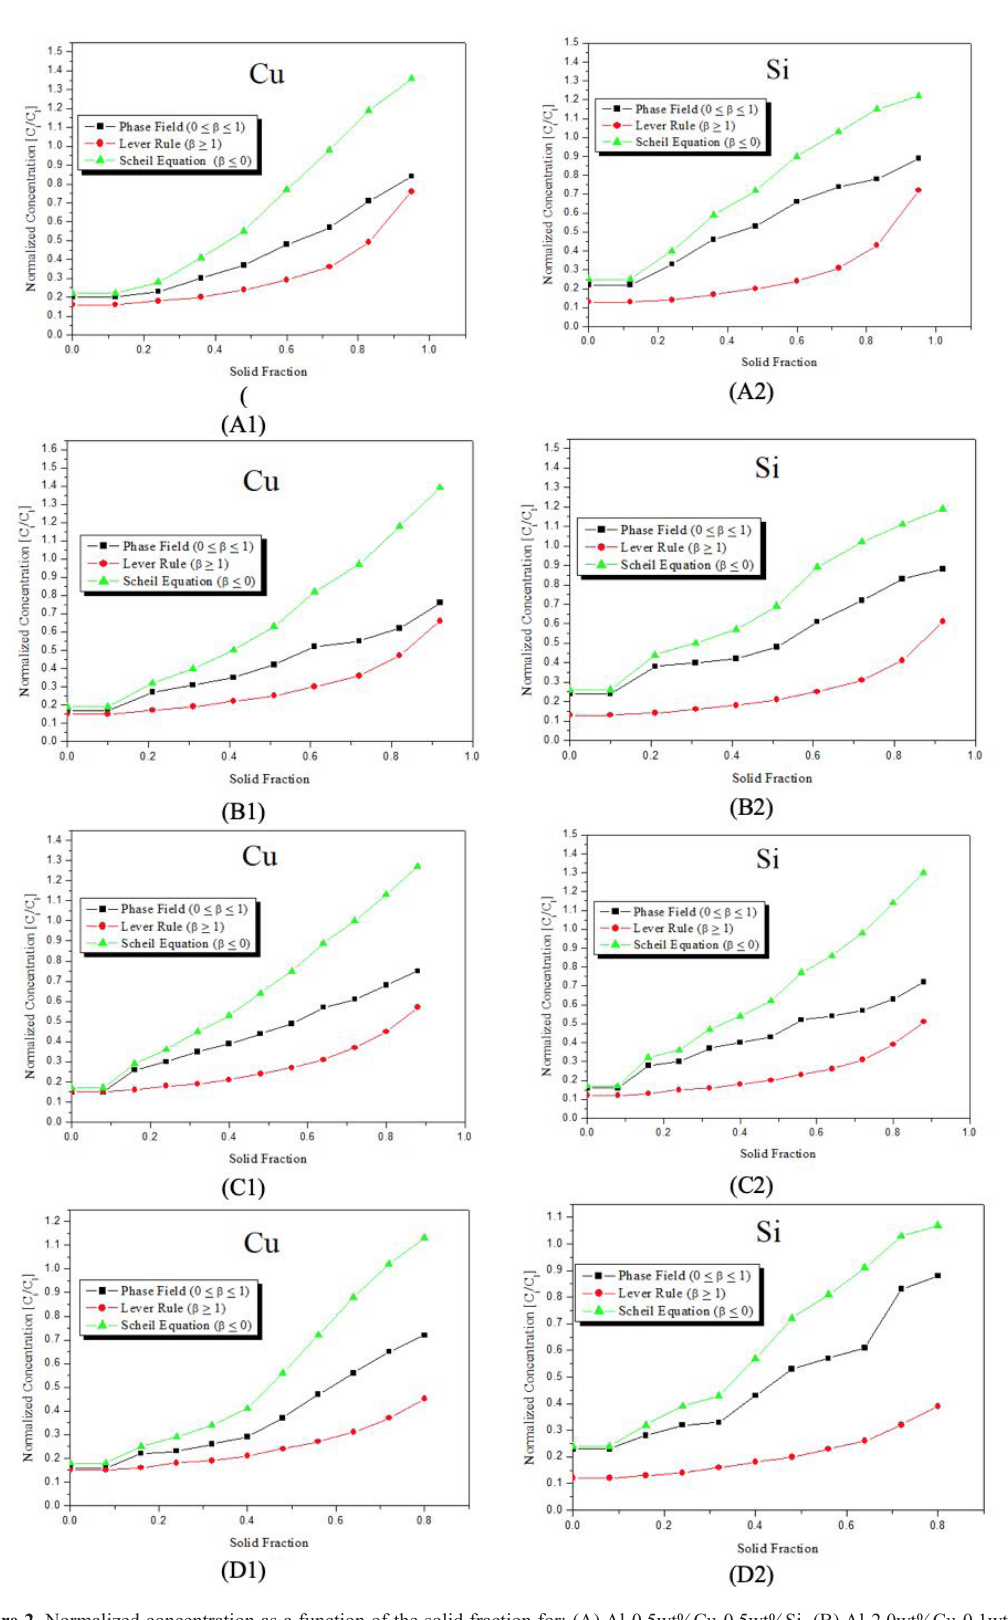
Figure 2. Normalized concentration as a function of the solid fraction for: (A) Al-0.5wt%Cu-0.5wt%Si, (B) Al-2.0wt%Cu-0.1wt%Si, (C) Al-2.0wt%Cu-1.0wt%Si, and (D) Al-4.0wt%Cu-0.1wt%Si